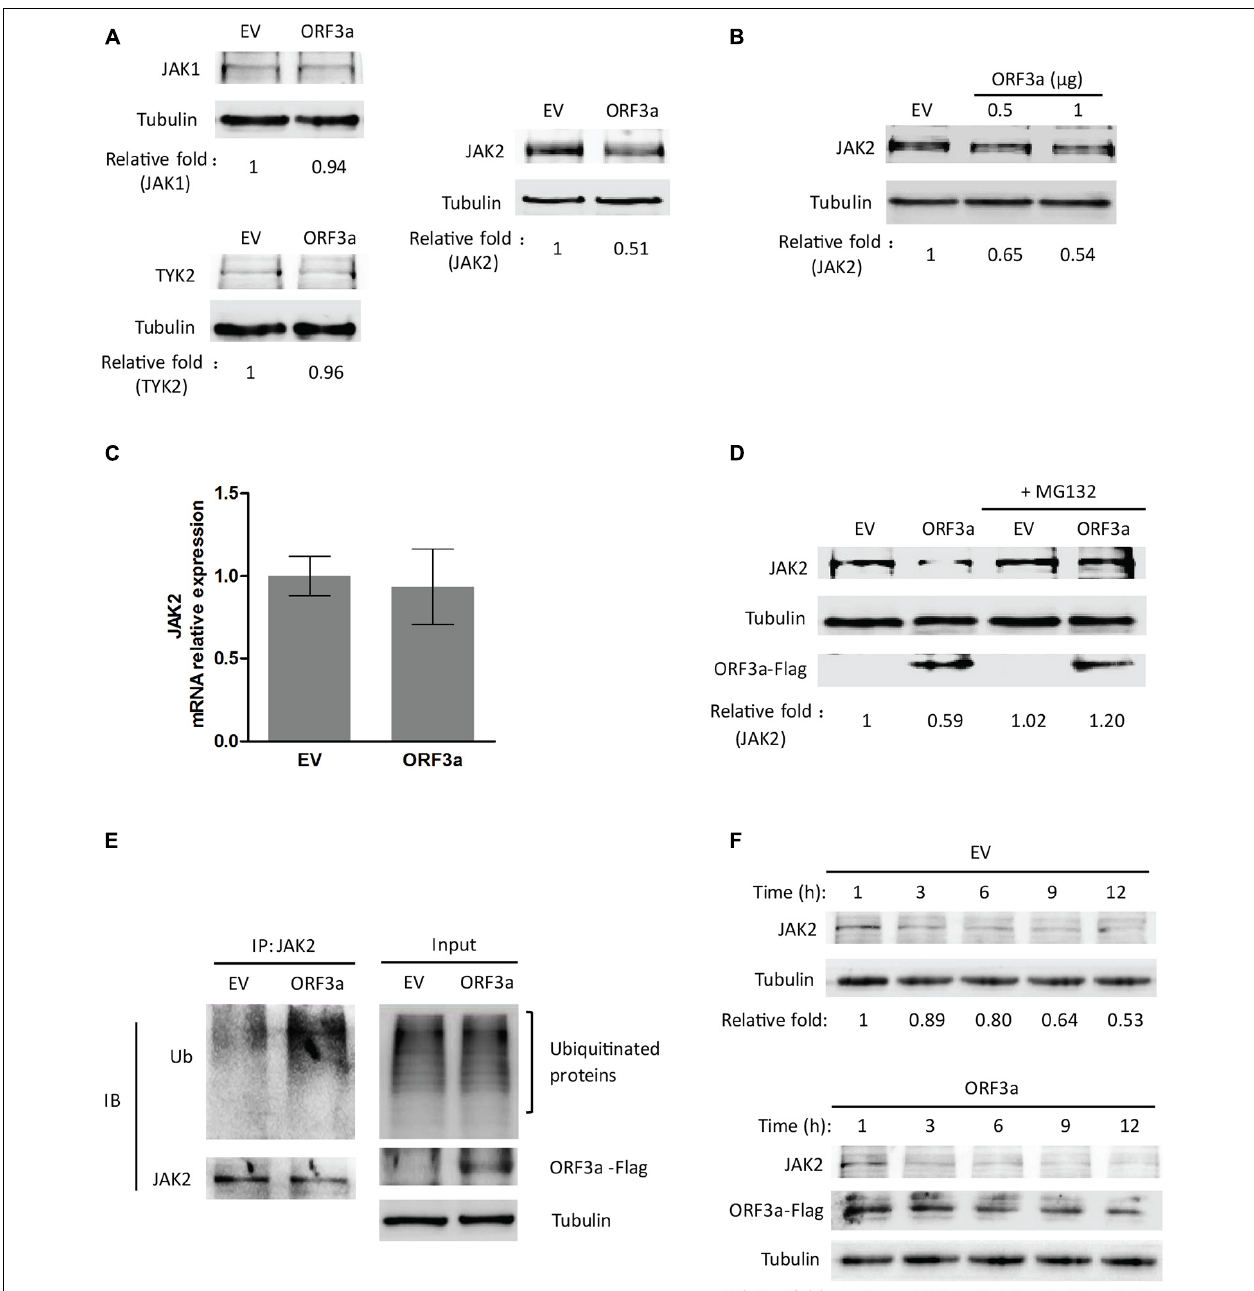
FIGURE 5 | ORF3a reduces JAK2 expression via the proteasome pathway. (A) ORF3a reduces the JAK2 level, but not JAK1 and TYK2. HEK293T cells were transfected with empty vector (EV) or ORF3a plasmid, then harvested for immunoblotting at 36 h post-transfection. (B) ORF3a decreases JAK2 in a dose-dependent manner. Cells were transfected with incremental amounts of ORF3a plasmid and then harvested for immunoblotting to determine the JAK2 level. (C) JAK2 mRNA level is not affected by ORF3a expression. HEK293T cells were transfected with EV or ORF3a plasmid. At 24 h after transfection, the cells were harvested for RNA extraction and RT-qPCR. Error bars represent standard errors of the results of repeated experiments. (D) JAK2 reduction in ORF3a-expressed cells is restored by MG132 treatment. HEK293T cells were transfected with EV or ORF3a plasmid. At 30 h after transfection, the cells were treated with MG132 for 6 h and then harvested for immunoblotting with antibodies against JAK2, Flag, and tubulin. Relative levels of JAK2 are shown as folds below the images after normalization with tubulin in densitometry analysis. (E) ORF3a increases JAK2 ubiquitination. The EV or ORF3a transfected cells were lysed with IP lysis buffer, followed by IP with JAK2 antibody. The input and IP products were subjected to immunoblotting with antibodies against ubiquitin (Ub), JAK2, Flag, and tubulin. (F) JAK2 half-life is shortened in the presence of ORF3a. HEK293T cells transfected with ORF3a plasmid were treated with cycloheximide (CHX) and harvested at indicated times (h) for immunoblotting. EV transfected cells were included as a control. Relative levels of JAK2 are shown as folds below the images after normalization with tubulin.